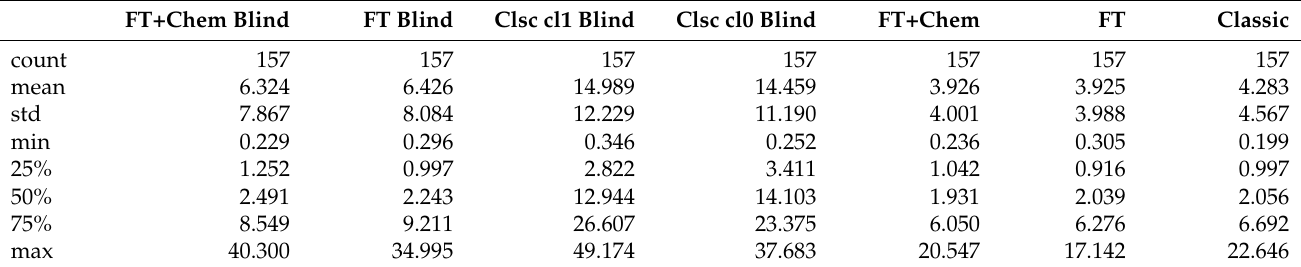
Table 3. Description of the distribution of RMSDs in each benchmarking protocol for PDBbind. FT+Chem Blind FT